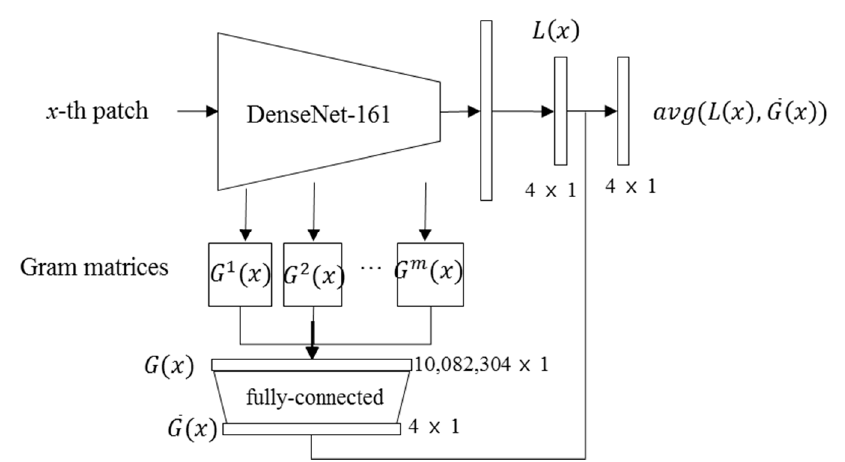
Figure 7. The process of decision making in a recognizing module.